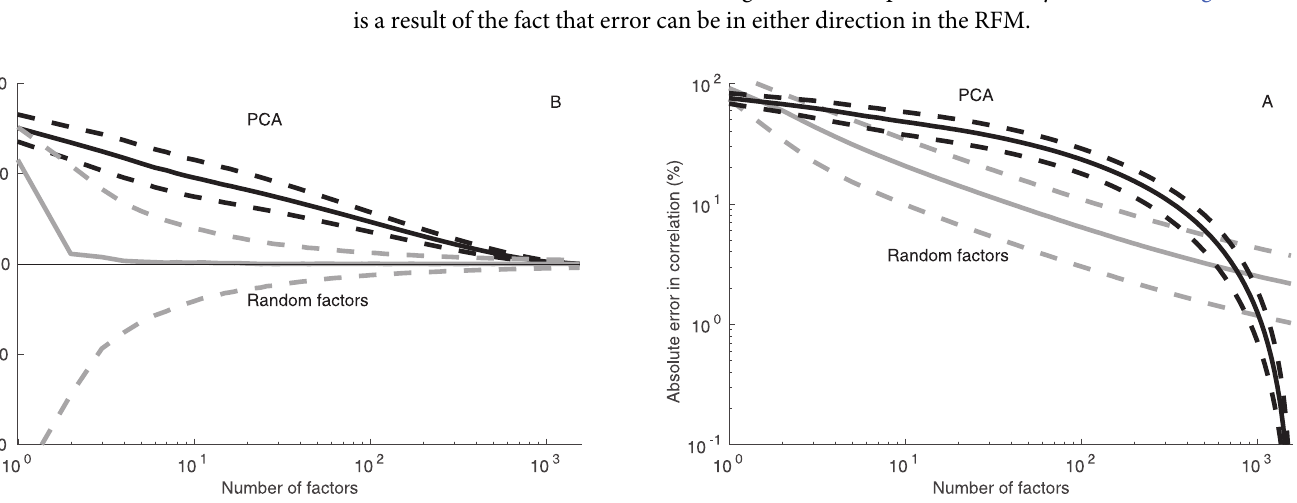
PLOS ONE | https://doi.org/10.1371/journal.pone.0206551 December21,